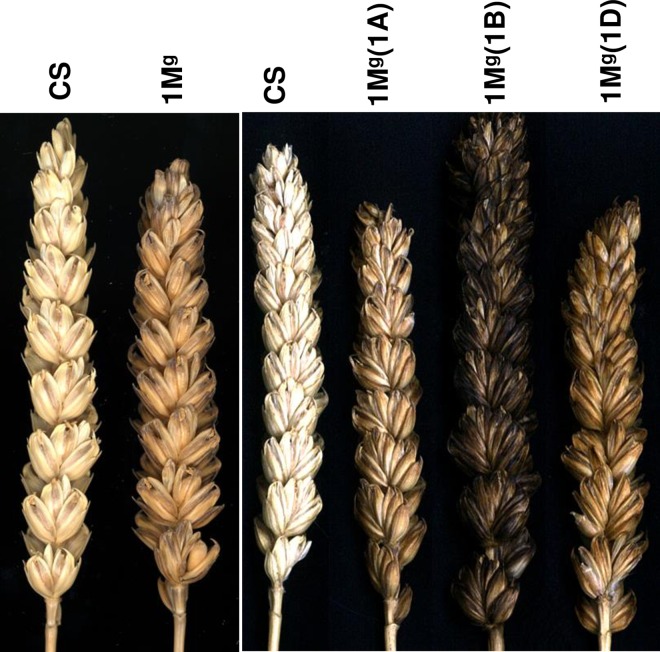
Spike morphology of CS, DAL1Mg and DSLs.Glume color of DSL1Mg(1B) was darker than other tested lines.